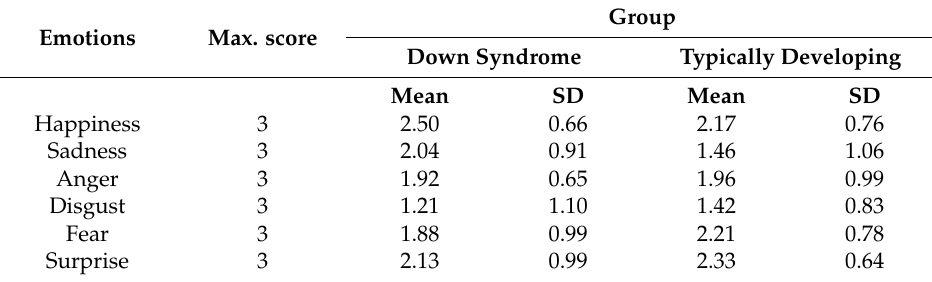
Table 3. Emotional scores in Raven’s Colored Progressive Matrices (RCPM) matched groups.